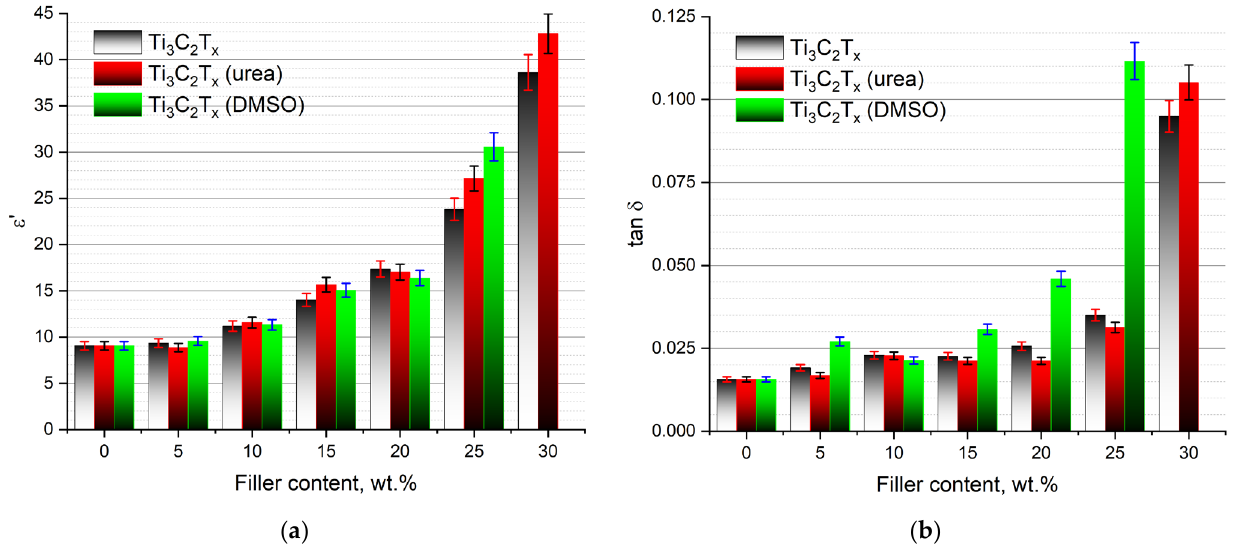
Figure 6. The dependences of ( a ) the permittivity and ( b ) dielectric losses of the PVDF/MXene nanocomposites on the filler loading at a frequency of 1 kHz.